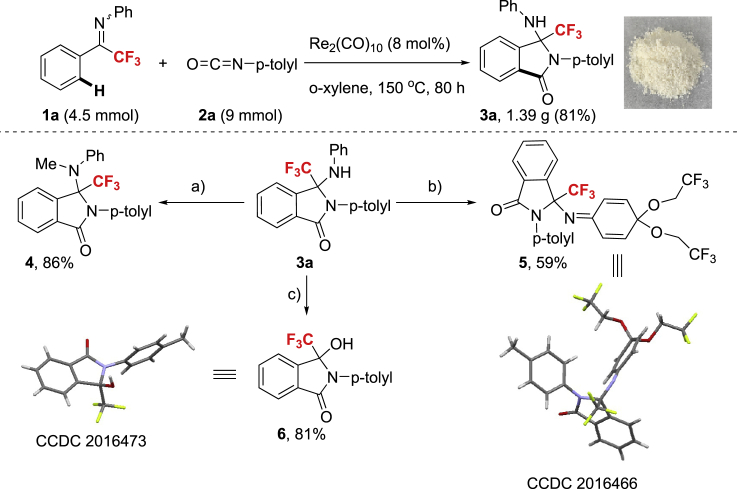
Synthetic ApplicationsReaction conditions: (a) LiHMDS (8.0 equiv.), MeI (8.0 equiv.), in THF under Ar, refluxing for 24 h; (b) PIDA (4.0 equiv.), Cs2CO3 (1.5 equiv.), in TFE, at 70 °C for 6 h; (c) BF3⋅Et2O (3.0 equiv.), in CH3CN, under Ar, at 80 °C for 24 h.